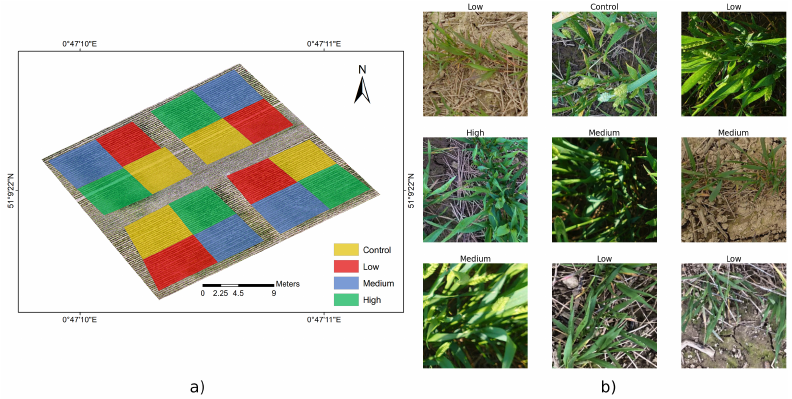
Figure 1. ( a ) Experimental layout, with plots randomly allocated into four treatments, split into four blocks. Treatments were high (green), medium (blue) and low fertilizer rates (red), and an unfertilized control (yellow). ( b ) Images collected from different plots with different